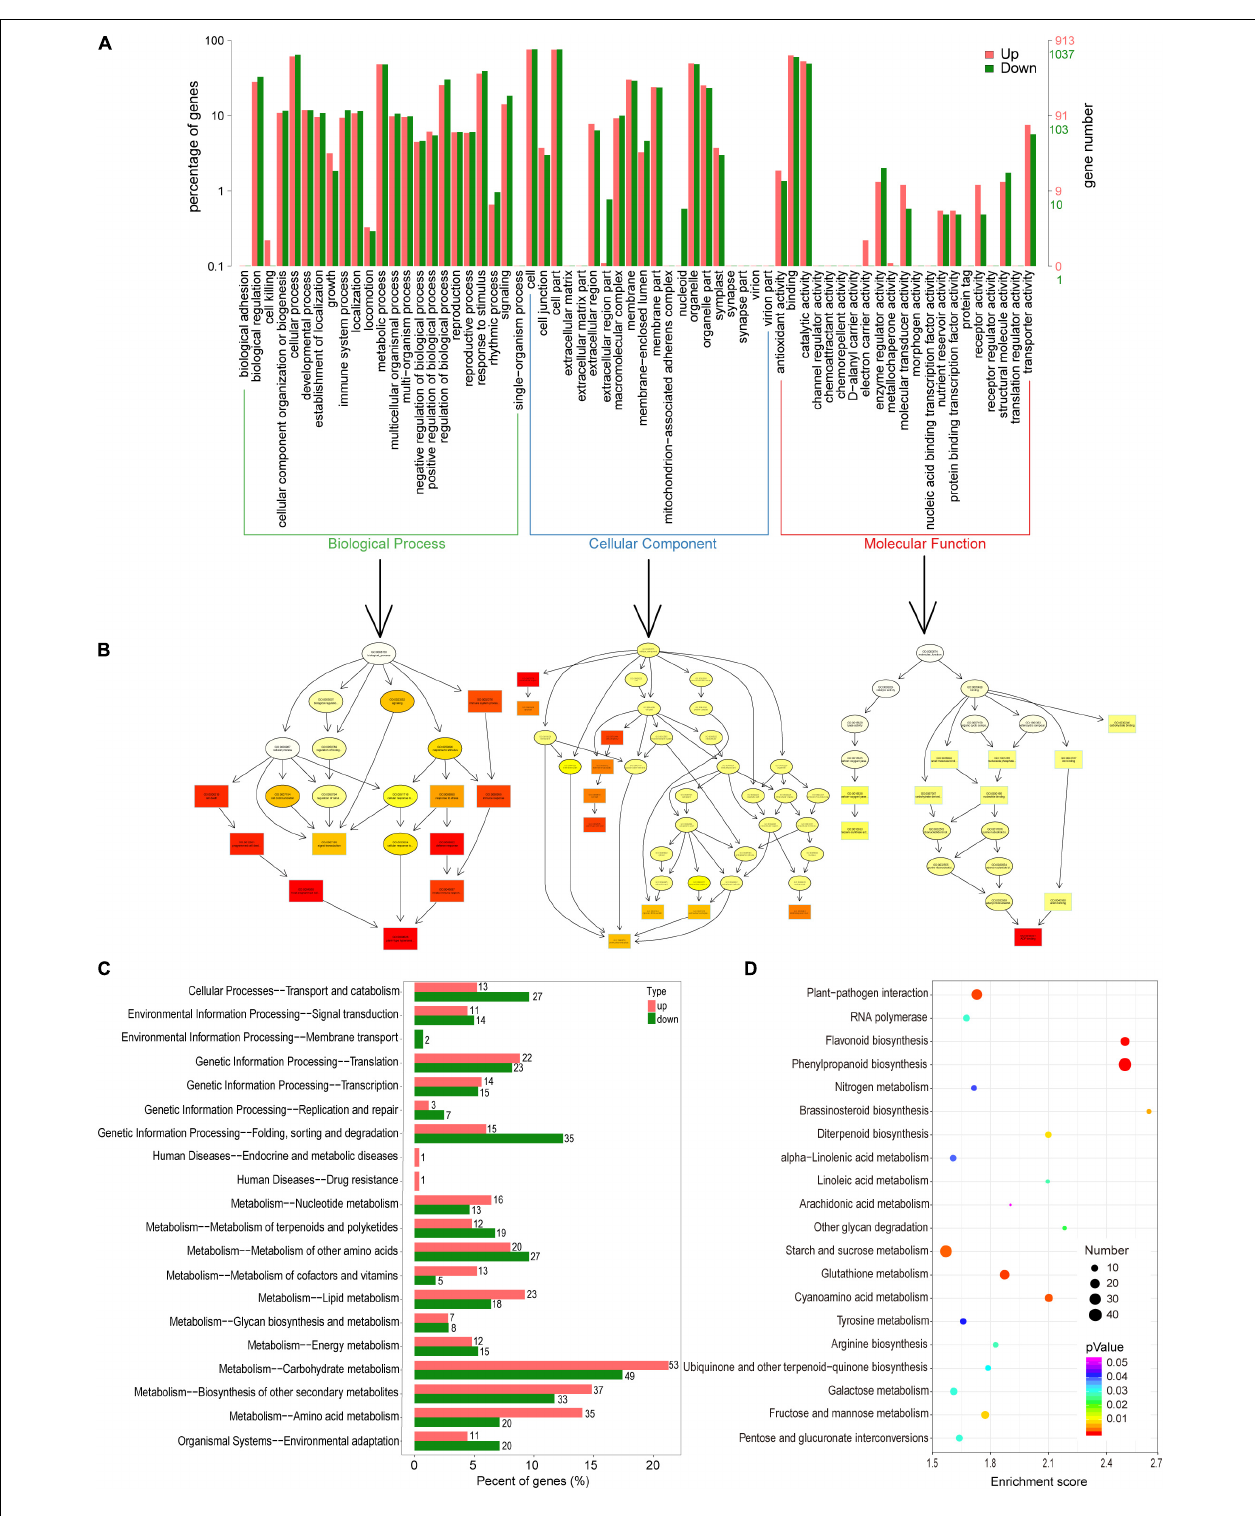
FIGURE 3 | Functional classification of differentially expressed unigenes (DEGs). (A) Comparison of the distribution of DEGs at the GO level. Red/green indicates GO entries enriched for up-/downregulated DEGs; the x -axis is the name of the entry, and the y -axis represents the number of unigenes in the corresponding entry and its percentage. (B) Directed acyclic graphs of three main categories. The 10 most significant nodes are represented by rectangles; the colors of the rectangles represent the significance of enrichment, and the significance increases as the color changes from yellow to red. The basic information on each node is displayed